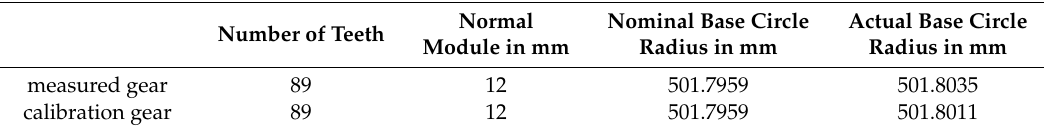
Table 1. Geometric parameters of the simulated gears.